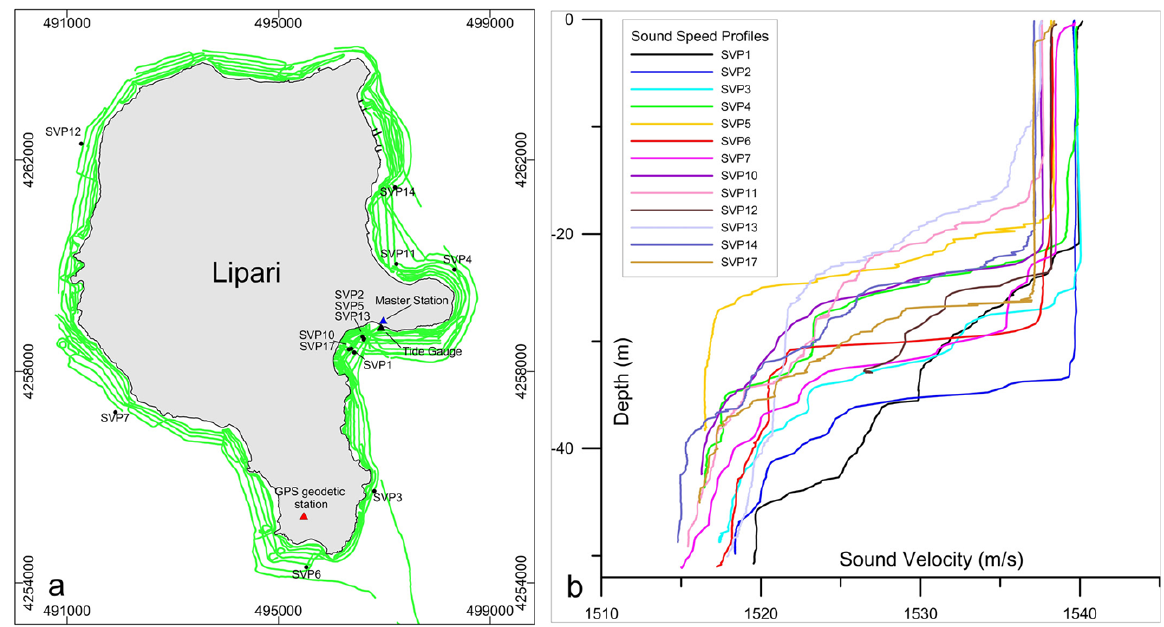
Figure 3. (a) Survey tracklines and positions of: i) tide gauge station (black triangle), ii) GPS master station (blu triangle), and iii) GPS geo- detic station LOSV (red triangle). The latter was used as reference during post processing analysis. (b) Sound velocity profiles (black circles; see Figure 3a for locations) collected during the multibeam